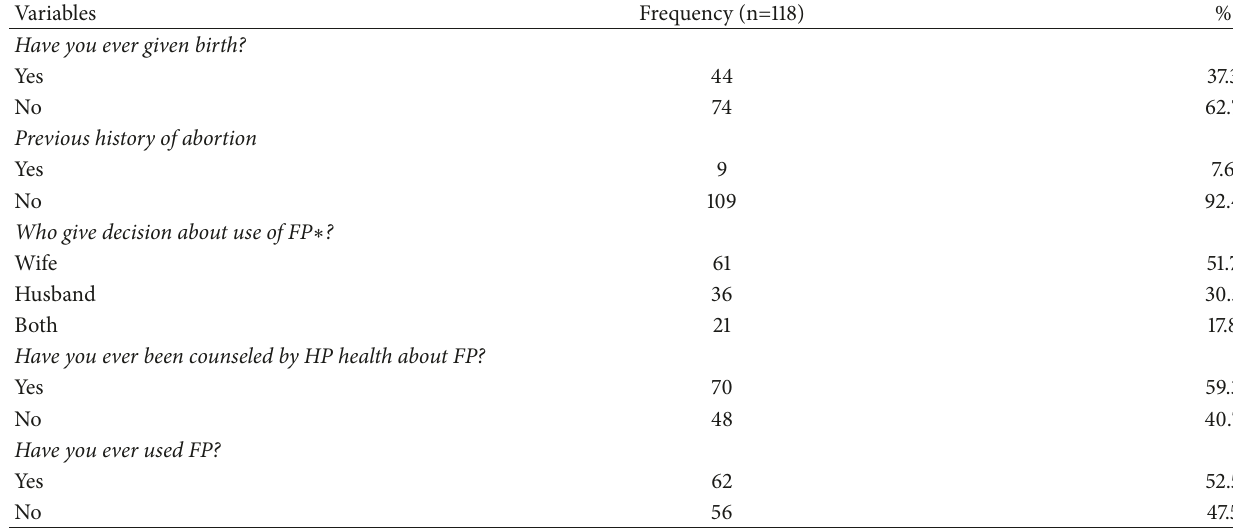
Table 3: Reproductive health, family planning, and abortion related characteristics of participants, Dessie, Amhara, Ethiopia, 2017.